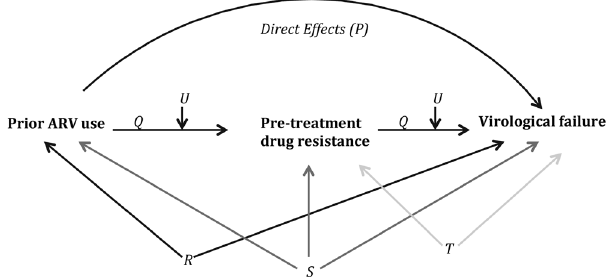
Figure 1. Direct acyclic graph (DAG) showing the relationship between prior ARV use, pre-treatment drug resistance and virological failure. P represents direct effects of prior ARV use on virological failure. Q represents indirect effects of prior ARV use on virological failure mediated through pre-treatment drug resistance. R represents confounders of the association between prior ARV use and virological failure: age and sex. S represents confounders of the association between pre-treatment drug resistance and virological failure that are affected by prior ARV use: pre-treatment viral load, CD4 cell counts and adherence. T represents confounders of the association between pre- treatment drug resistance and virological failure not included in S: type of initial antiretroviral treatment (NNRTI and NRTI) initiated and calendar year of treatment initiation. U represents unmeasured confounders. We note that the DAG is only a simple illustration and this may exclude complex relationships interacting between prior ARV use/pre- treatment drug resistance/virological failure and their